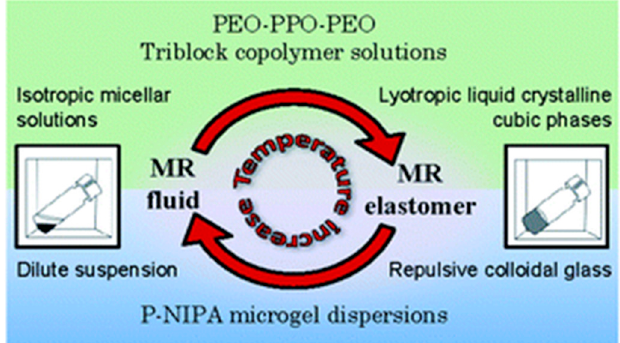
Figure 1. Magneto-rheological (MR) fluid to magneto-rheological elastomer (MRE) transition as a function of temperature. Reprinted from [3], © 2005 with permission from RSC.